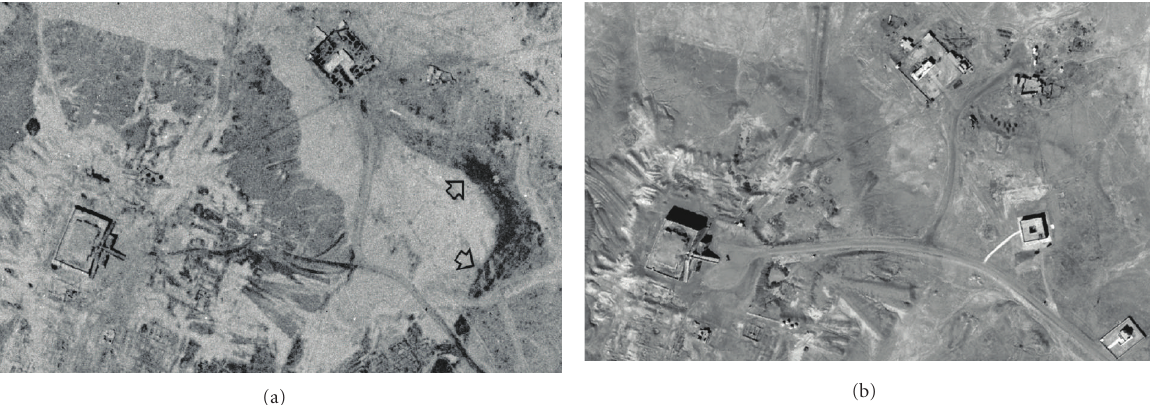
Figure 15: The area of the North Harbour in a Gambit KH-7 photo of 1966 (a) and in the WorldView-1 image of 2008 (b): the arrows show the traces and remains of the northern and north-eastern